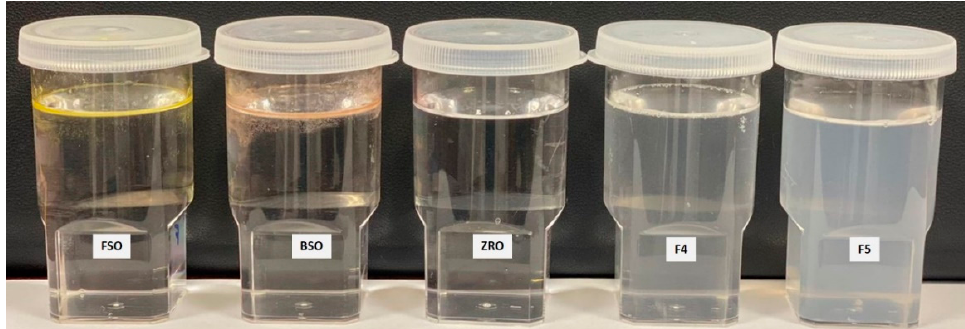
Figure 4. Physical appearance of the formulation upon aqueous dispersion (anhydrous formulation was diluted at a 1:1000 dilution factor).